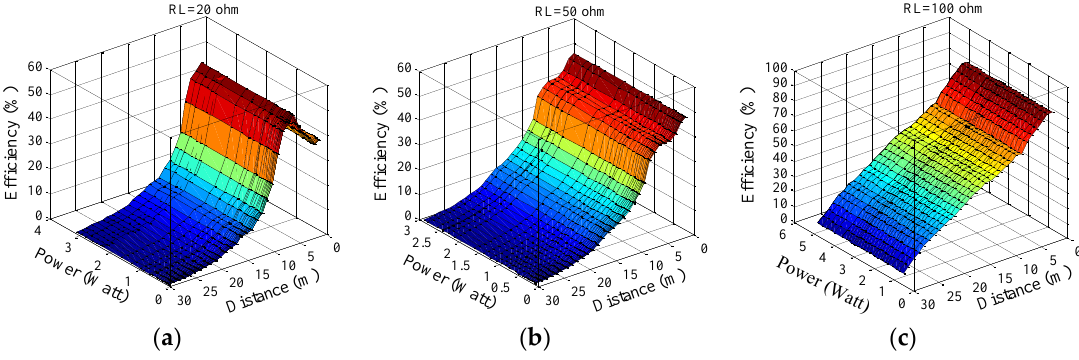
Figure 12. The relationship between output power and transfer efficiency versus distance with the following loads: ( a ) 20 Ω ; ( b ) 50 Ω ; and ( c ) 100 Ω .